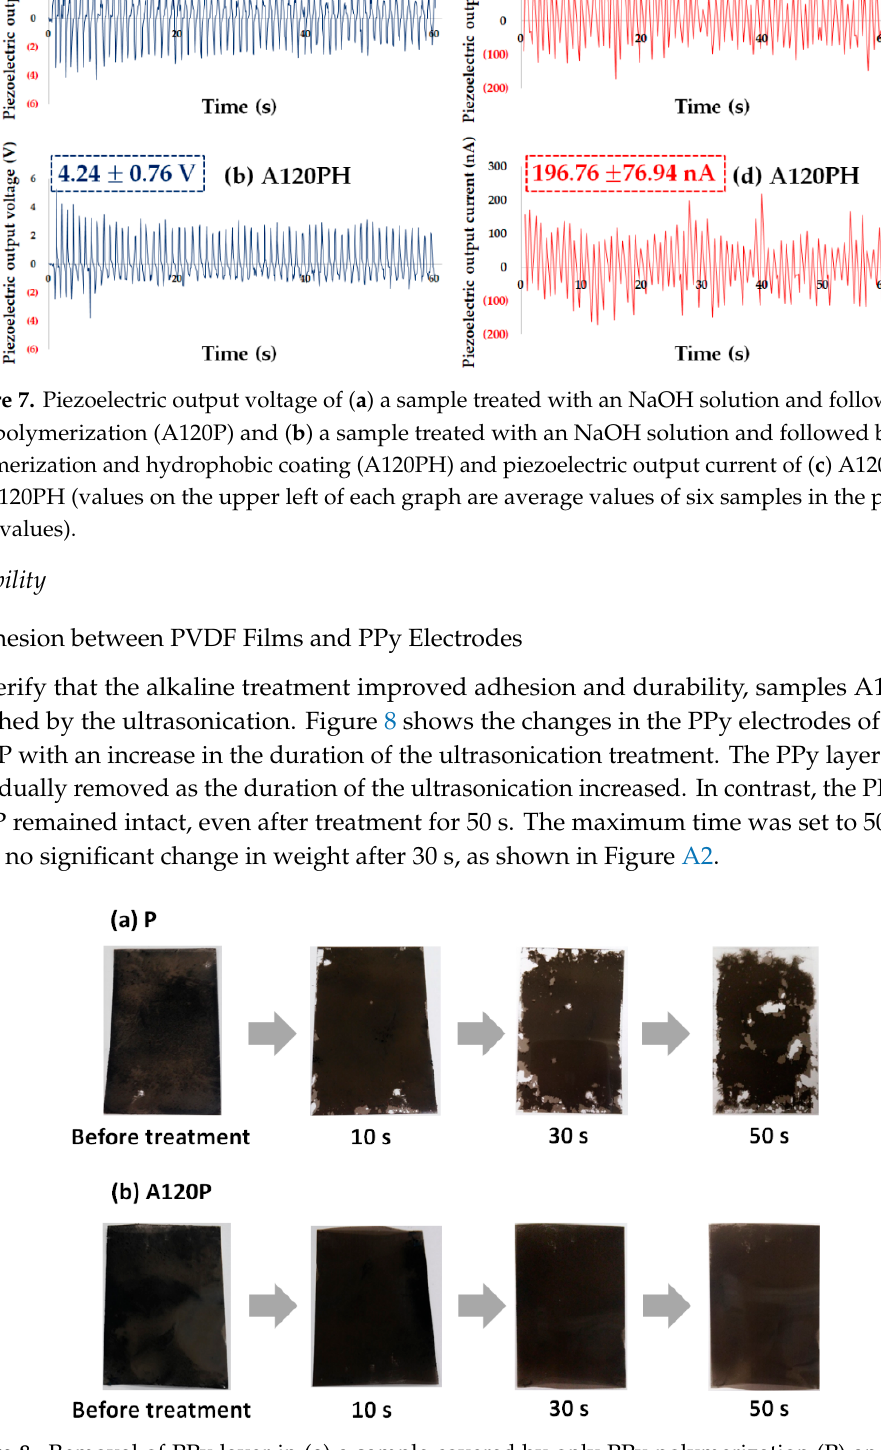
Figure 8. Removal of PPy layer in ( a ) a sample covered by only PPy polymerization (P) and ( b ) a sample treated with an NaOH solution and followed by PPy polymerization (A120P) according to the duration of the ultrasonication.